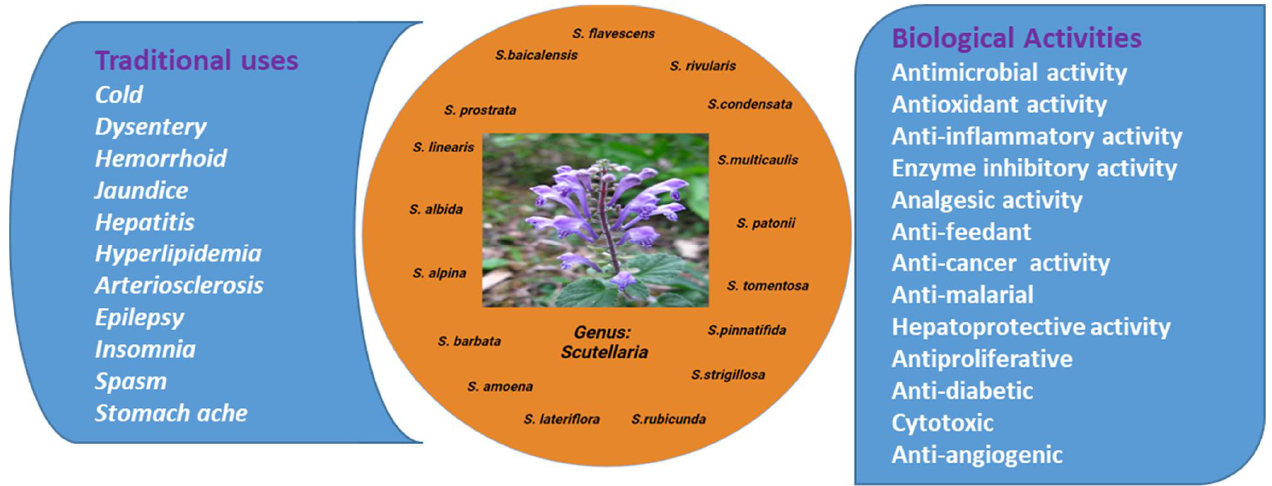
Figure 1. Traditional and biological applications of the genus Scutellaria .